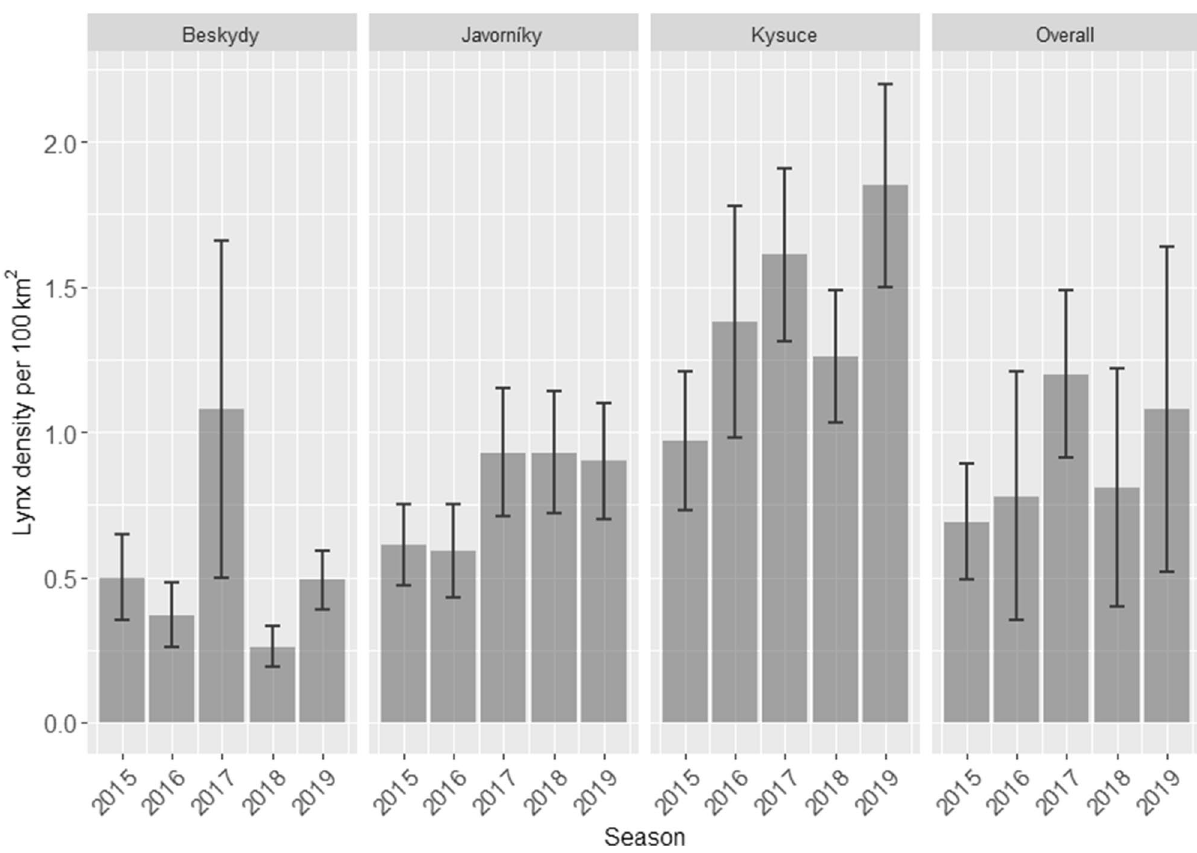
Figure 2. Estimates of Eurasian lynx density obtained by systematic camera-trapping during five consecutive seasons in three study sites (posterior mean ± SD) and average values for the whole region (average ± SD) in the Western